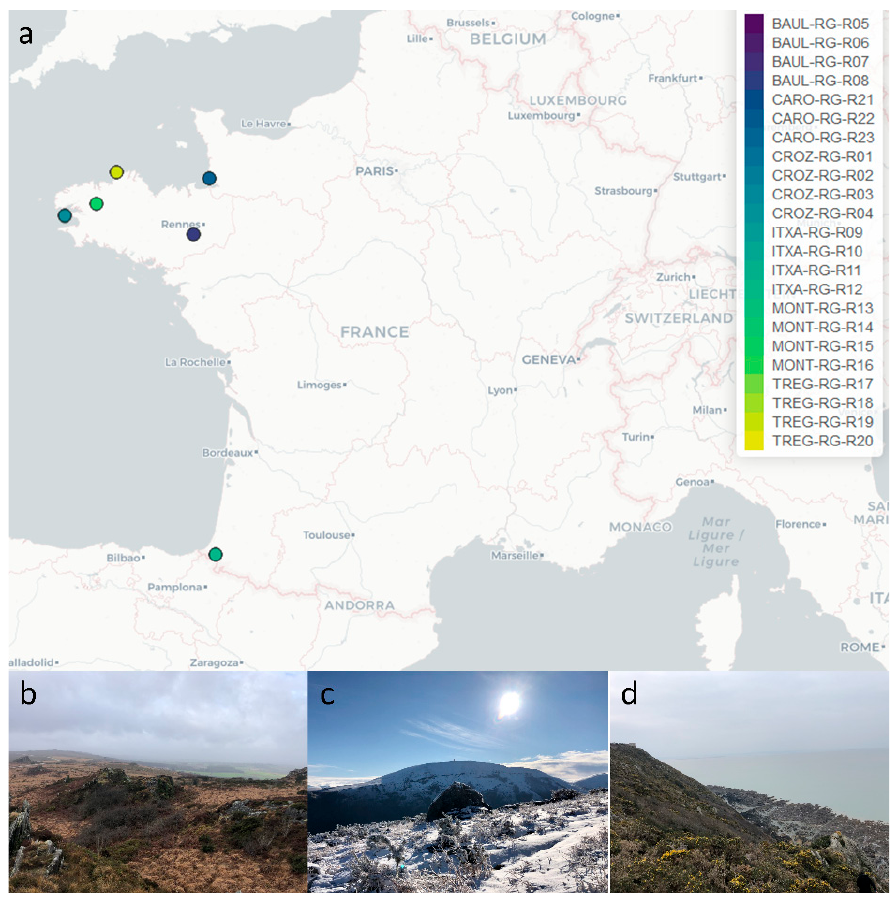
Figure 1. Rhizocarpon geographicum populations. ( a ) Locations where populations were sampled across France (north and south). Colored dots represent the R. geographicum populations (6 geographic sites), and the color gradient within the same localities indicates the different harvest locations. Four populations per site were sampled. ( b ) MONT populations, ( c ) ITXA populations, and ( d ) CARO populations, which are examples of the diversity of the terrestrial and maritime habitats harboring R. geographicum .